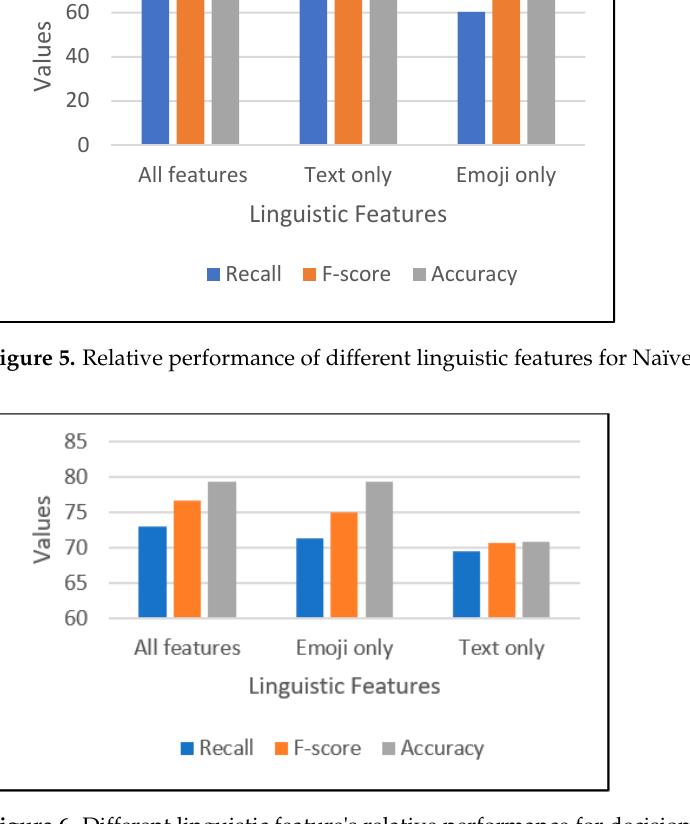
Figure 6. Different linguistic feature's relative performance for decision tree classifier.